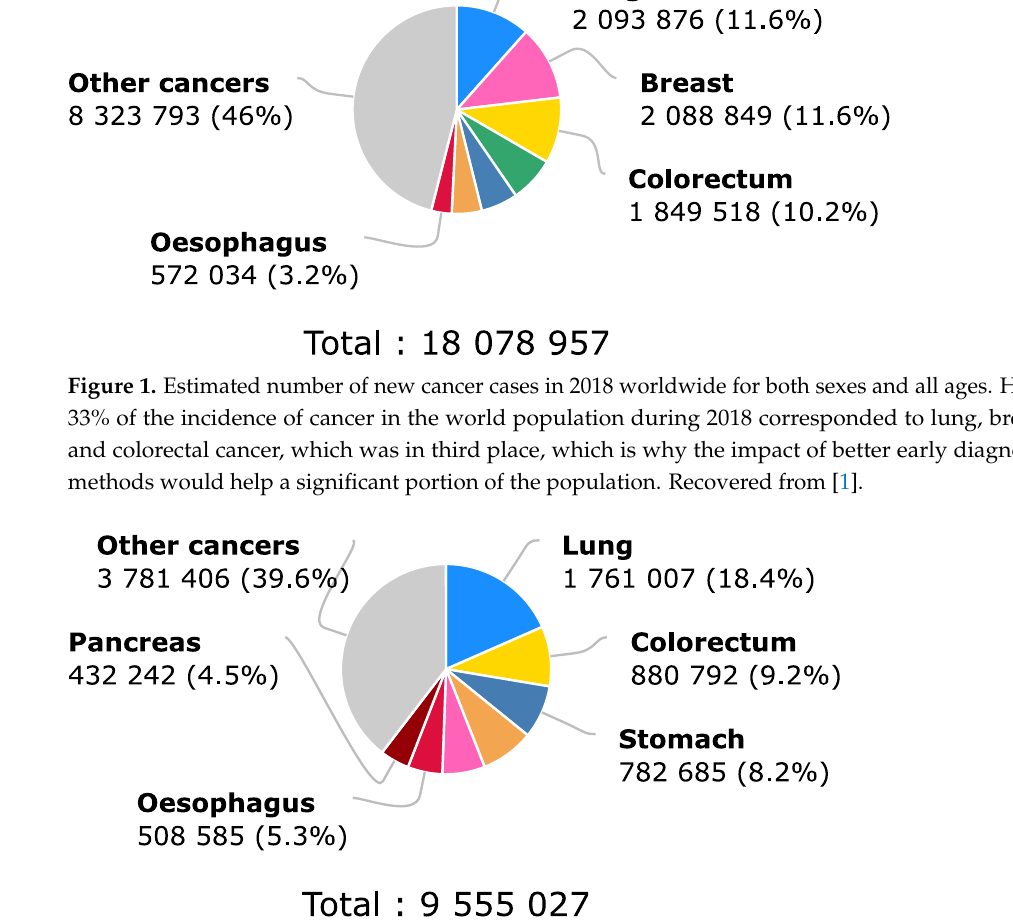
Figure 2. Estimated number of deaths due to cancer in 2018 globally for both sexes and all ages. Colorectal cancer is positioned as the second cancer with the highest mortality during the year 2018. This is due in part to late diagnosis of the disease. Earlier detection could help reduce the 9.2% death rate. Recovered from